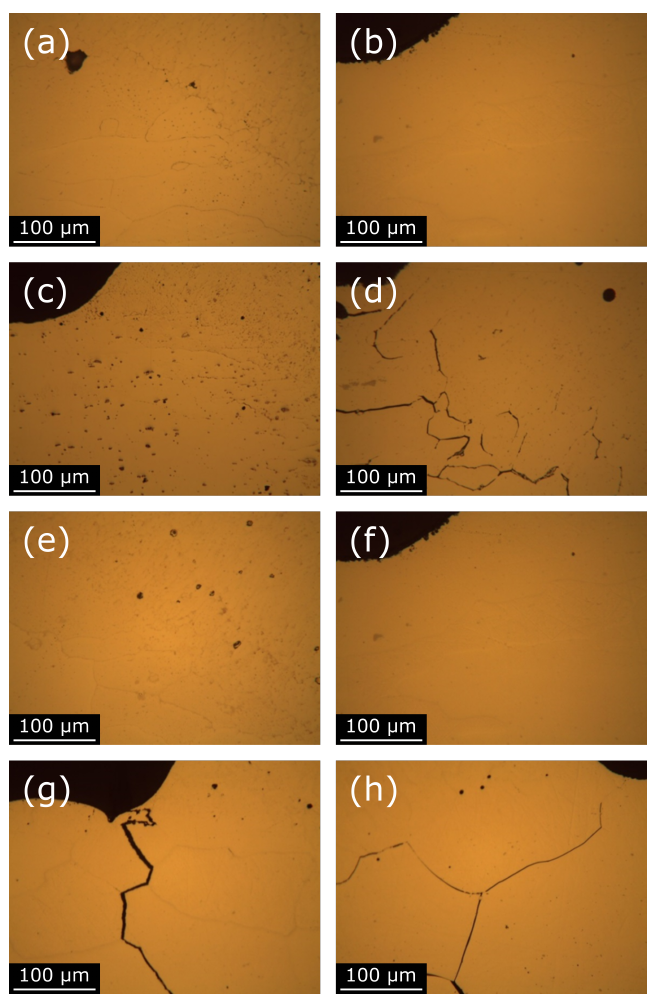
Figure 7. Optical images of ISDM before (left column) and after (right column) heat treatment for the four configurations with the ( a , b ) 2219, ( c , d ) 2024, ( e , f ) 2050 and ( g , h ) 2139